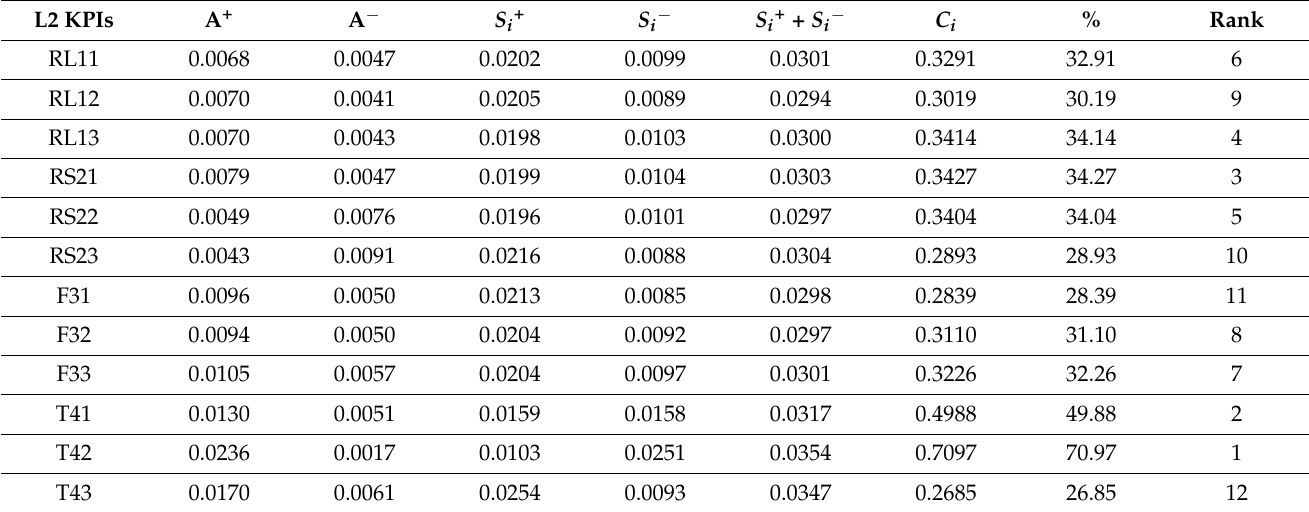
Table 7. Final results of TOPSIS for scenario 2 attributes.